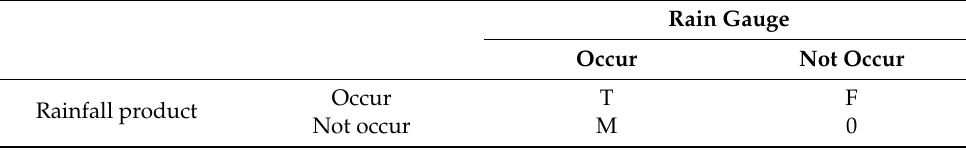
Table 5. Contingency table for satellite